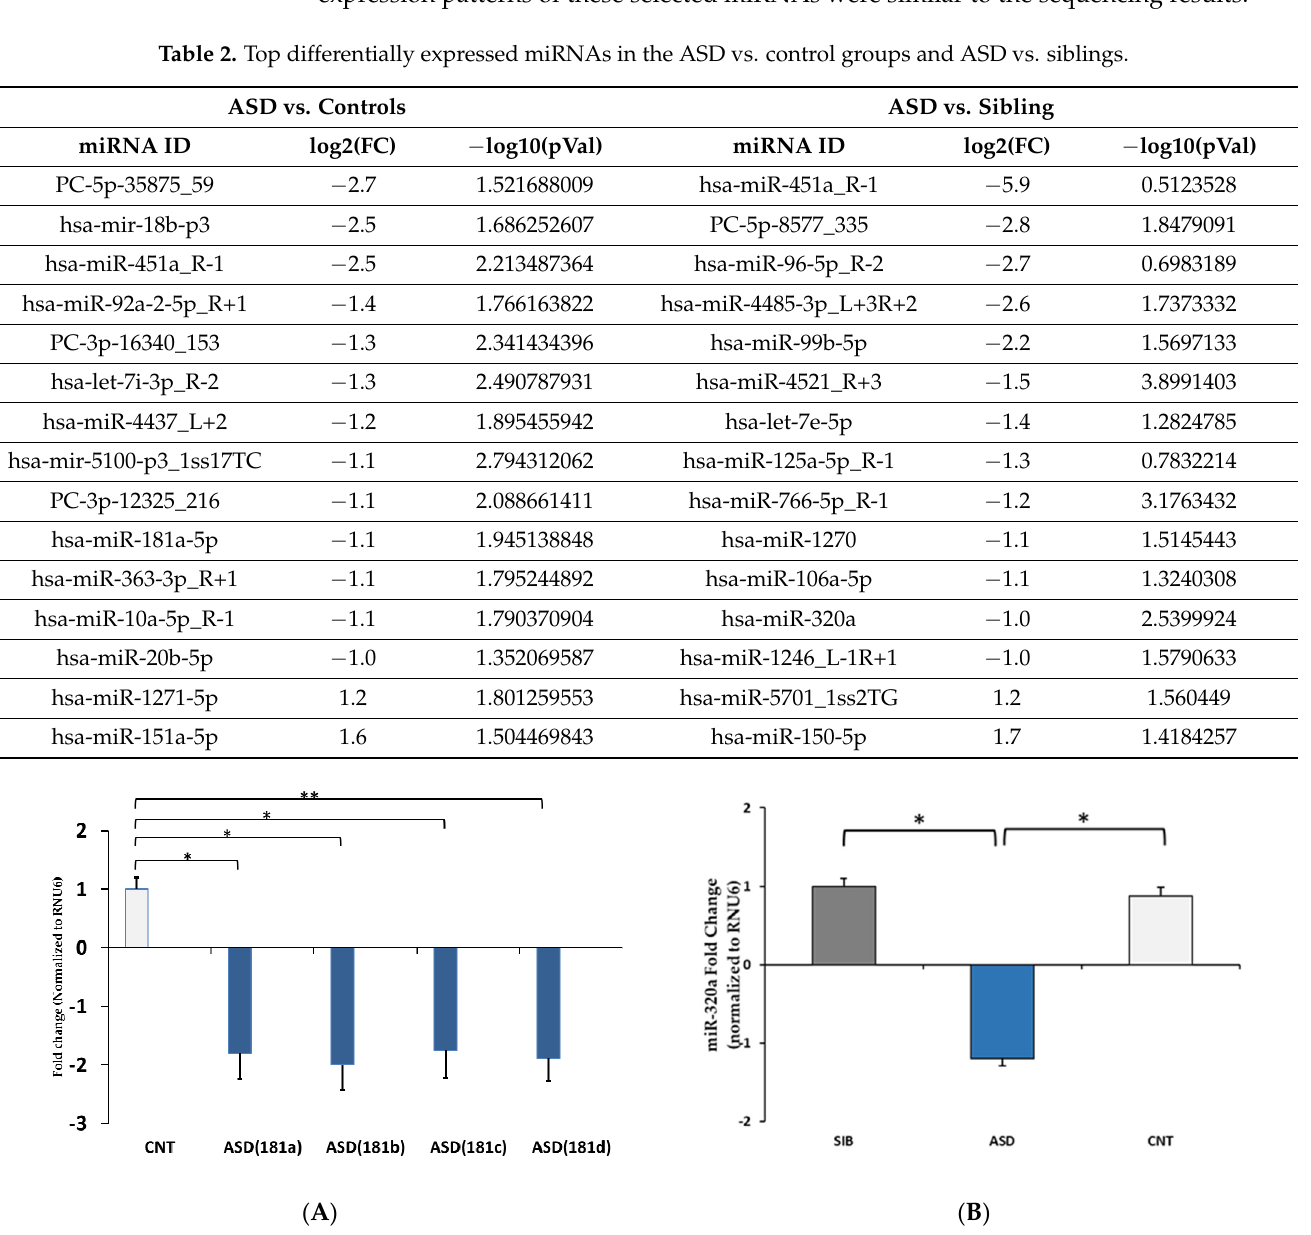
Figure 3. qPCR validation of miRNA expression: ( A ) miR-181a and other miR-181 family members (181b-5p, miR-181c-5p, and miR-181d-5p) and ( B ) miR-320a in LCLs. SIB = siblings; CNT = controls; ASD = autism spectrum disorder; data are means ± SEM of n = 9–10 samples in each category. Error bars represent standard error of the mean. miRNA expression was normalized to RNU6 for each group. * p ≤ 0.05.; ** p ≤ 0.01.